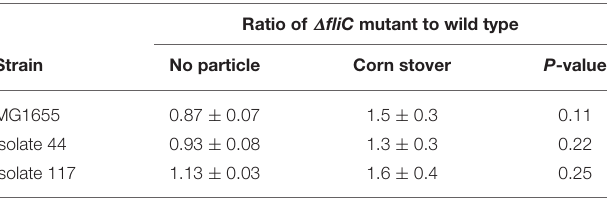
TABLE 1 | Flagella have little impact on attachment to corn